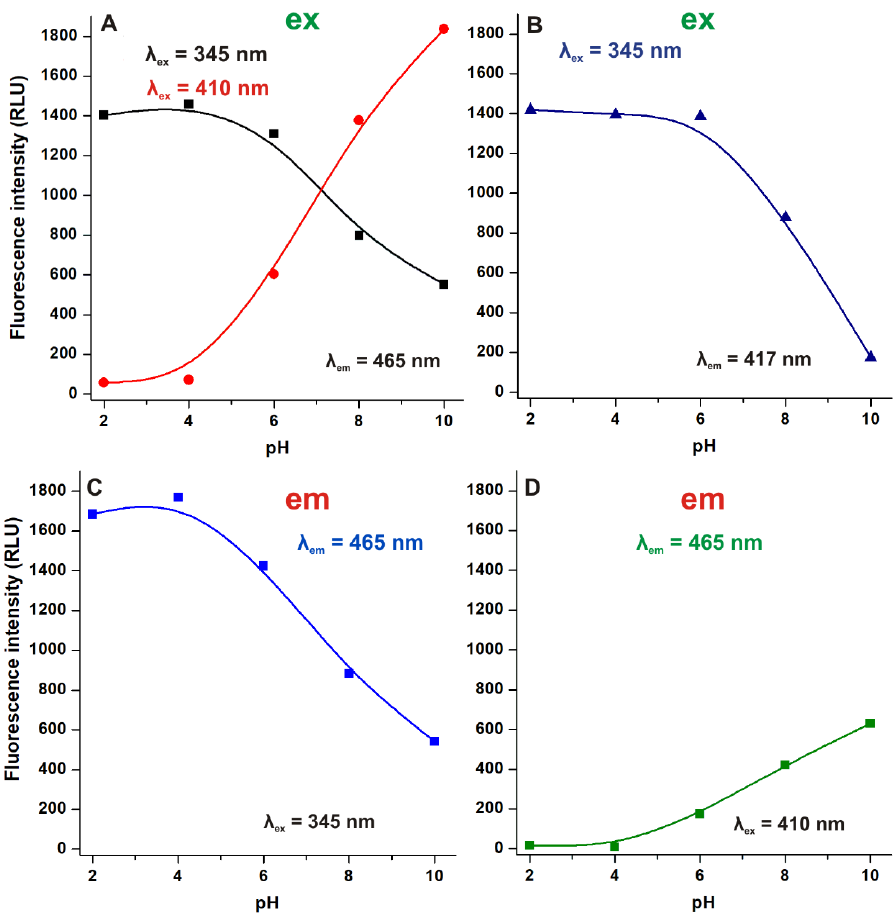
Figure 2. Excitation ( A and B : ex and em slits were 10 nm) and emission ( C ): ex and em slits were 10 nm; ( D ): ex and em slits were 5 nm and 10 nm, respectively) signals of AOH (25 μ M) in sodium ( D ): ex and em slits were 5 nm and 10 nm, respectively signals of AOH (25 µ M) in sodium phosphate phosphate buffers (pH 2.0, 4.0, 6.0, 8.0, and 10.0; RLU: relative light unit). buffers (pH 2.0, 4.0, 6.0, 8.0, and 10.0; RLU: relative light